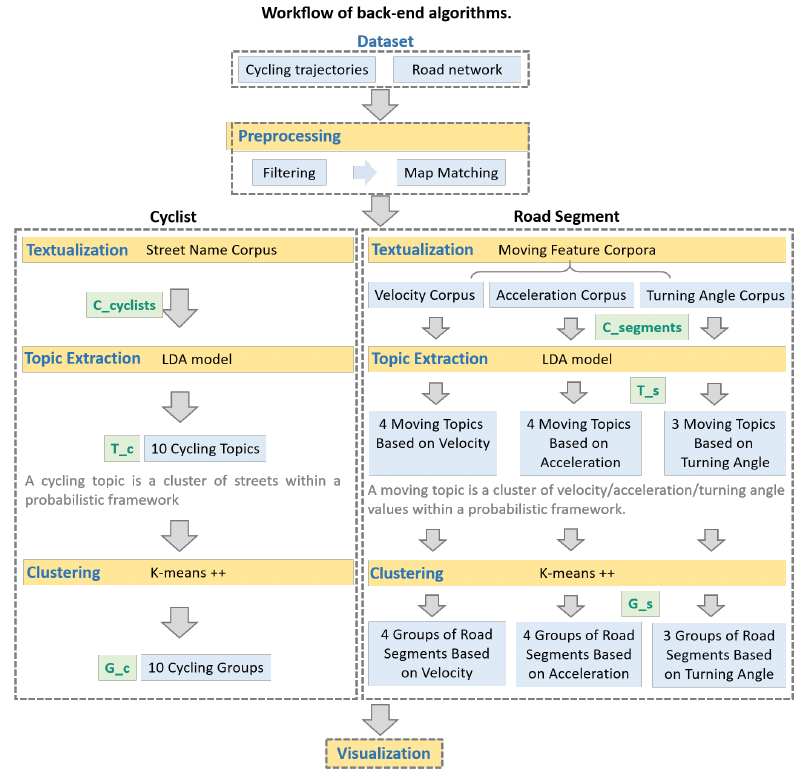
Figure 2. Workflow of backend